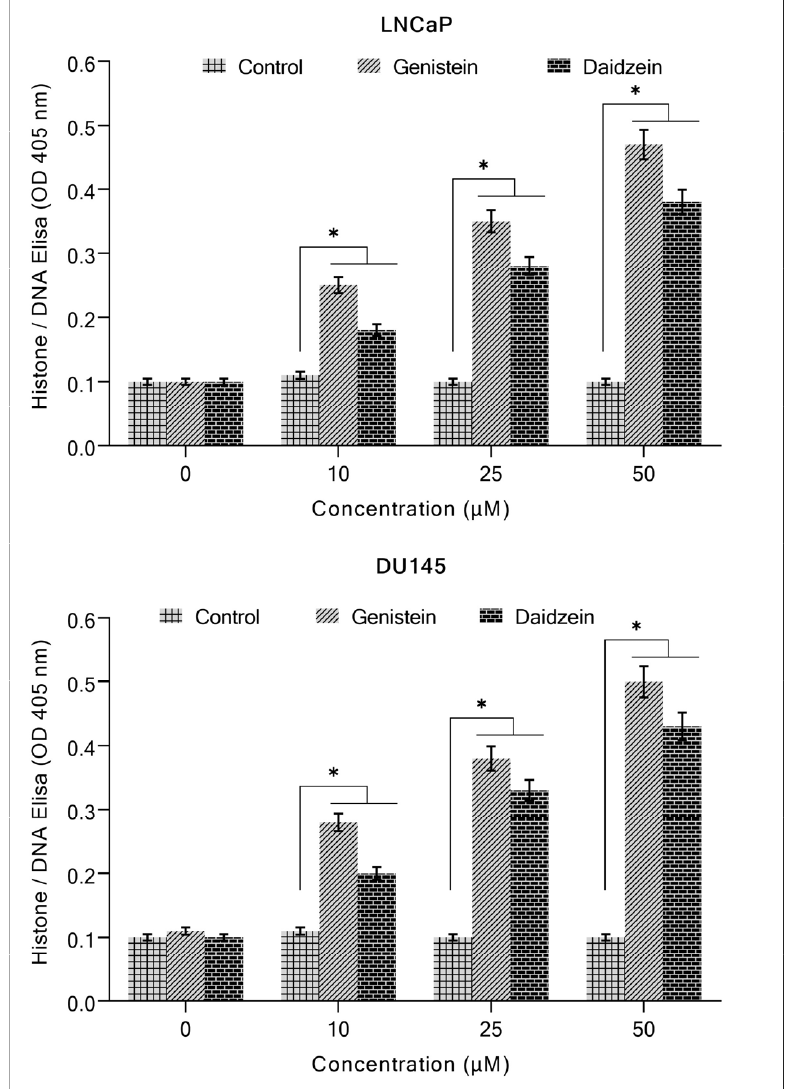
Figure 3. Analysis of genistein and daidzein on apoptosis in prostate cancer cell lines. After incubating prostate cancer cell lines for 96 h with increasing doses of both the isoflavones, apoptosis was detected using the Cell Death Detection ELISA Kit (Roche, Palo Alto, CA, USA), as shown in the figure and discussed in Section 4. Values reported are mean ± S.E of three independent experiments. * p value < 0.01 when compared to control.